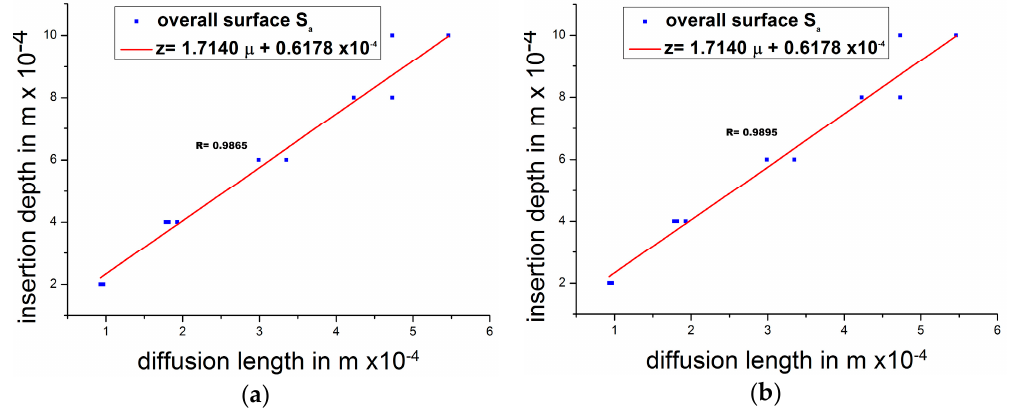
Figure 15. Correlation results after: ( a ) selecting a sound area from the background; and ( b ) selecting the entire surface as a sound area.